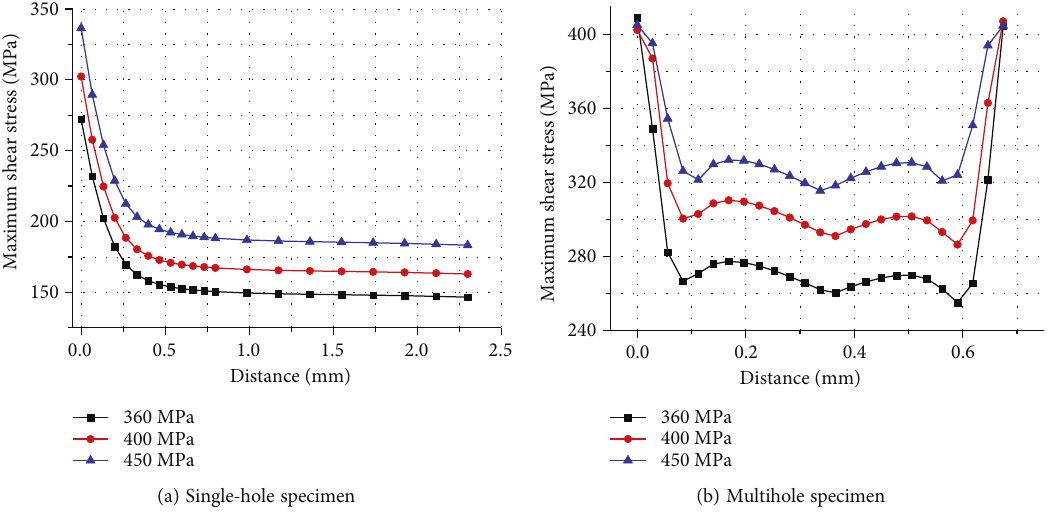
Figure 8: Maximum shear stress along the dangerous